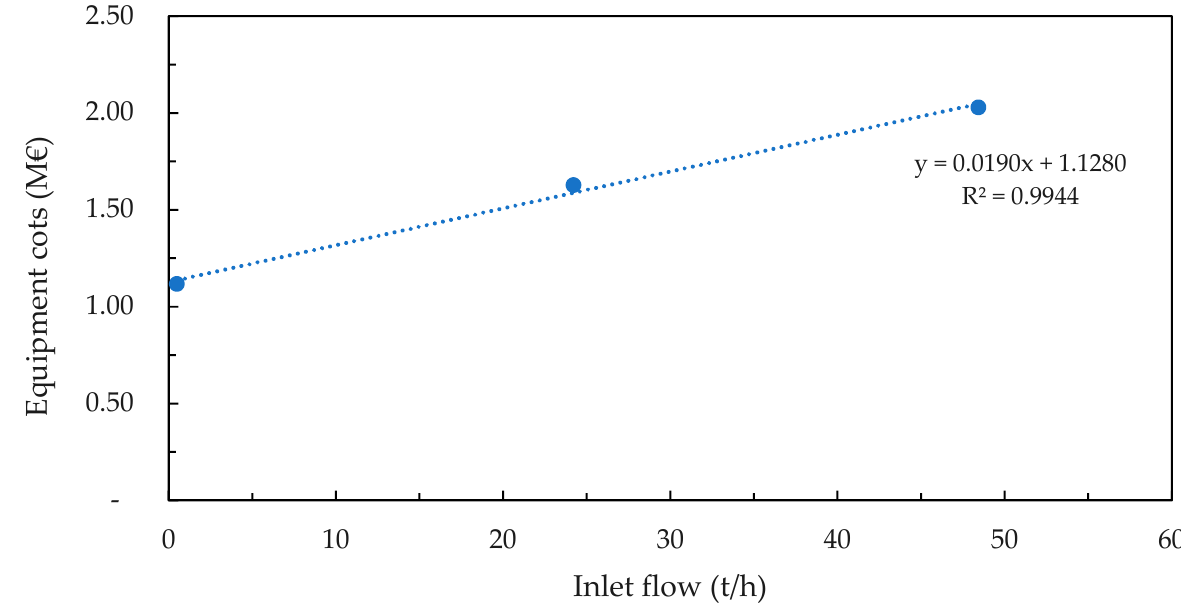
Figure A1. Equipment cost function for compressor of upgraded SynFeed (H 2 /CO 2 = 3) from 0.9 bar to 22.2 bar.